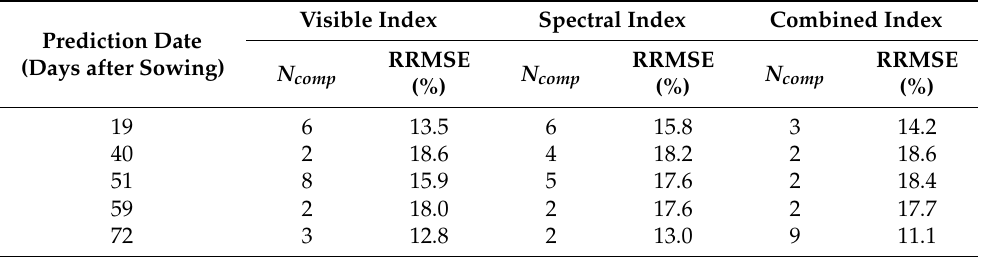
Table 3. The optimal number of components ( N comp ) and relative root mean square error (RRMSE) for training the PLSR models to estimate the aboveground dry weight of wheat. The models were trained using mono-temporal datasets of the visible, spectral, and combined indexes at prediction dates.